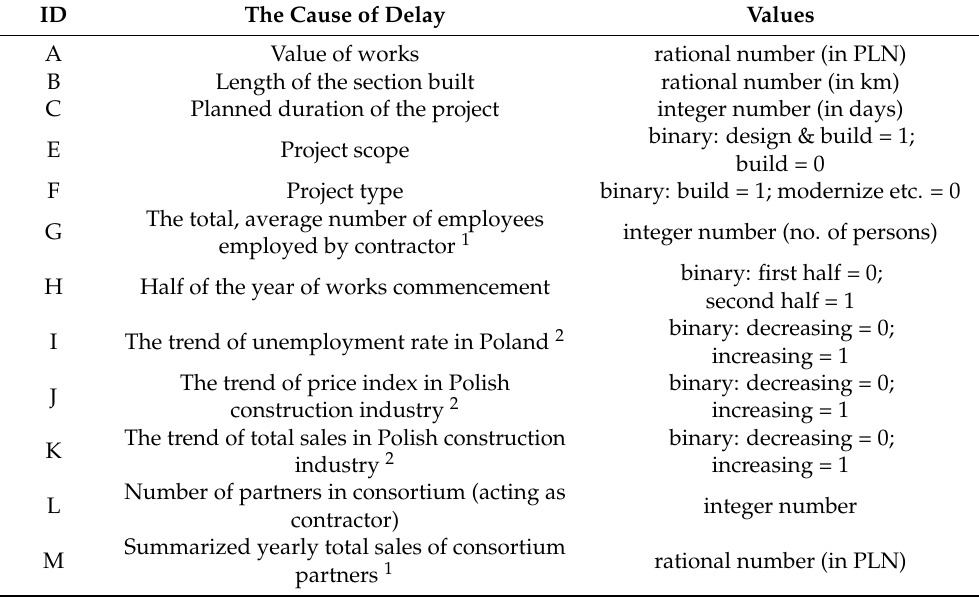
Table 2. Possible causes of delays and their values